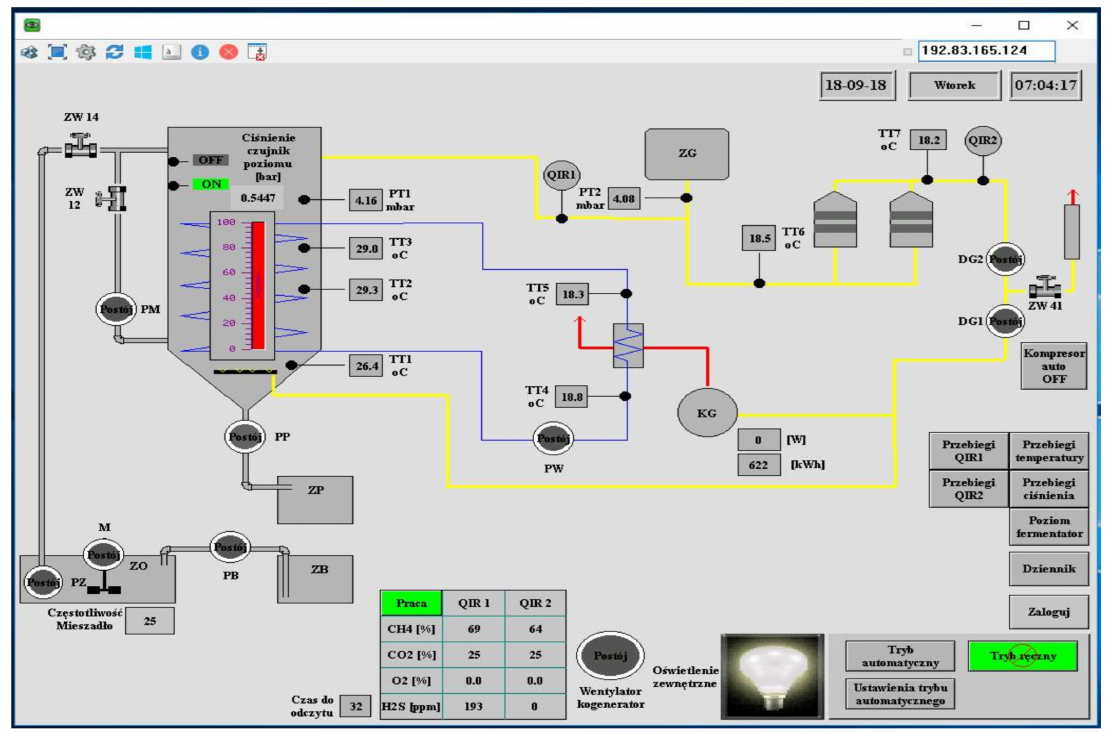
Figure 7. Synoptic board of the biogas plant control and visualization system (Ultra VNC software) (photo by Grze- gorz Wałowski): DG = gas blower, KG = co-generator, M = agitator, PB = biomass pump, PM = mixing pump, PP = digestate pump, PW = water pump, PT = pressure, PZ = submersible pump, QIR = gas analyser, TT = temperature, ZB = biomass tank, ZG = gas tank, ZO = operating tank, ZP = digestate tank, ZW = valve; the meaning of the descrip- tions in the diagram: “Post ó j”—“Stop”; “Cz˛estotliwo´s´c Mieszadło”—”Frequency Stirrer”;“Ci´snienie czujnik